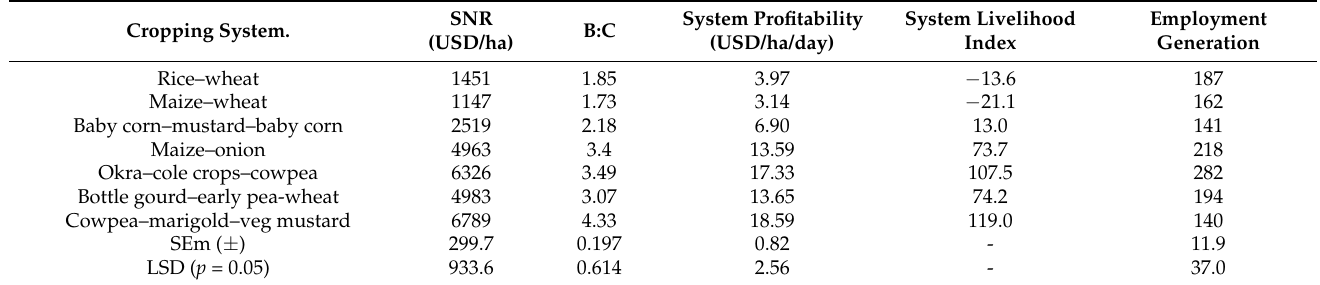
Table 5. System net returns, benefit cost ratio, profitability, system livelihood index (%), and employ- ment generation (man-days) of cropping system modules.